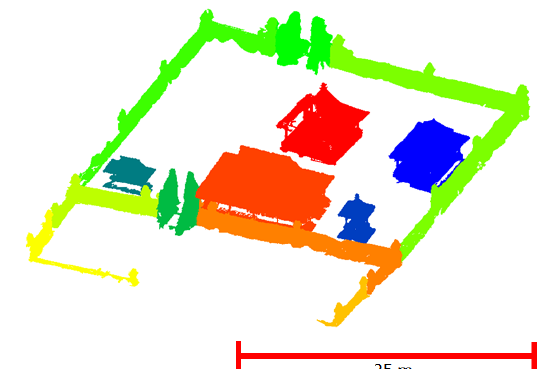
Figure 8. The final output of the algorithm, colour-coded for each segmented object cluster (regardless of